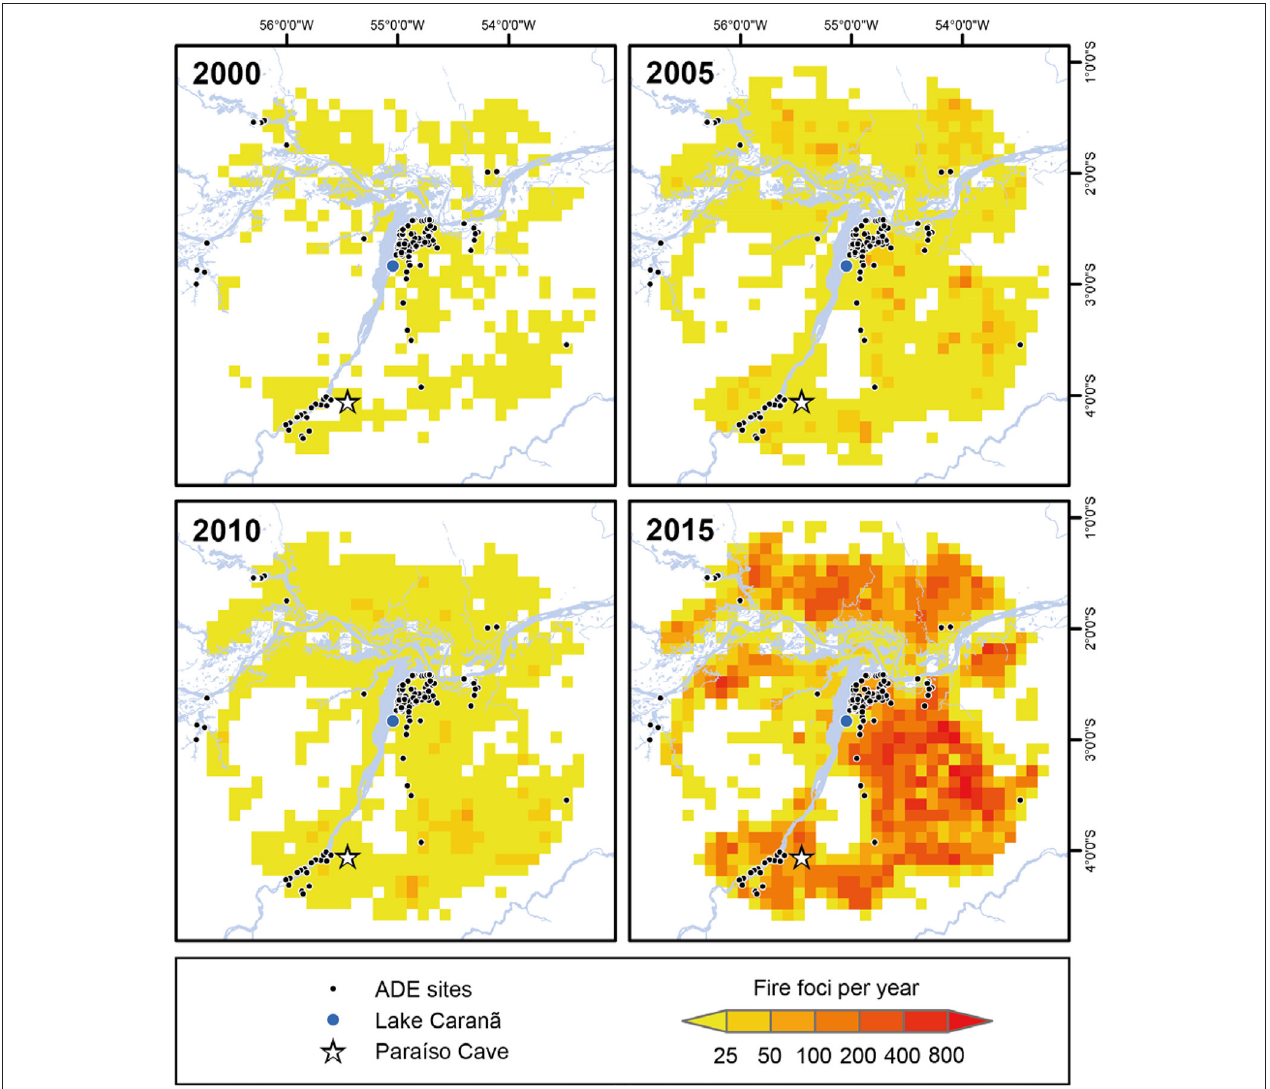
FIGURE 9 | The progressive increase in fire activity in the eastern Amazon from 2000 to 2015. The total number of fire foci per 0.1 square decimal degree at 5-year intervals between 2000 and 2015 within a 100-km radius around Lake Caranã. Data on fire activity for the period 1999-2017 were obtained from the online database of the Brazilian National Institute of Spatial Research (INPE) (http://www.inpe.br/queimadas/portal). The raw data represent fire foci at least 30 m 2 detected on satellite imagery of varying